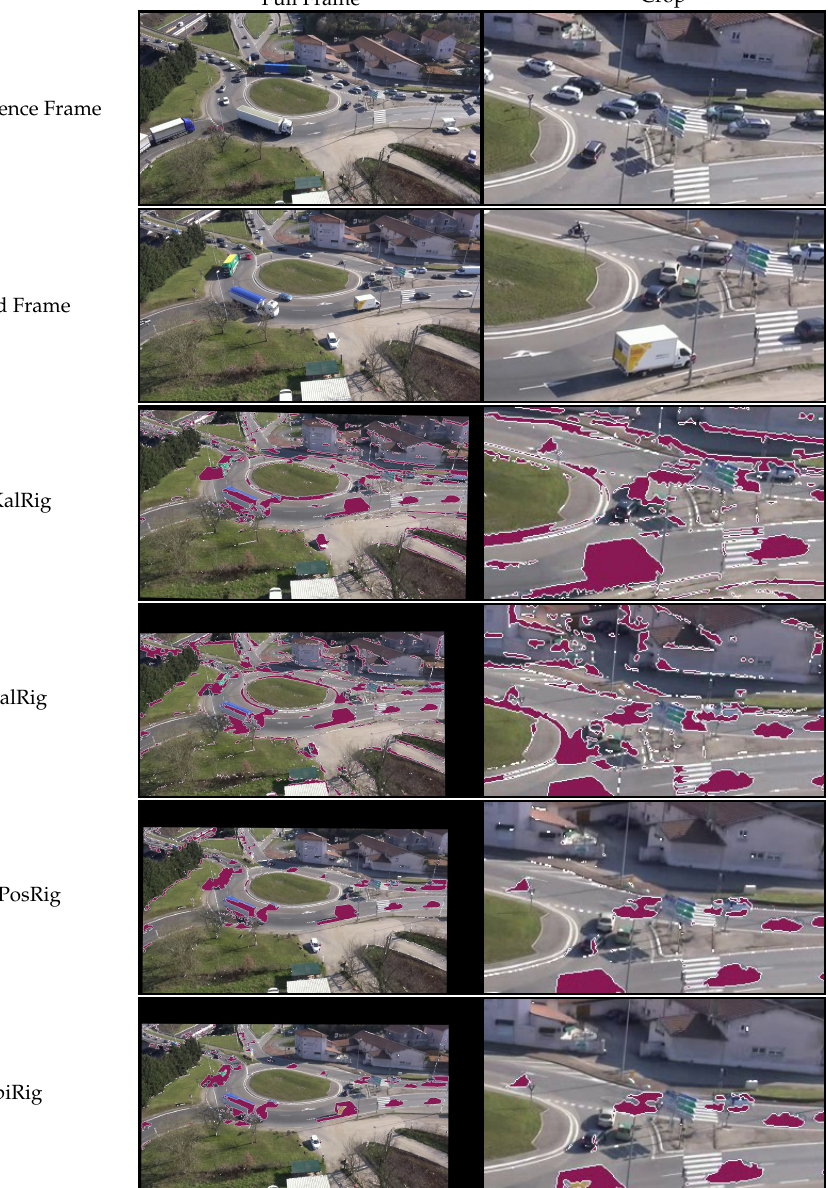
Figure 10. Results from tested 2D-rigid methods on the sequence MFull. The test-frame was picked approximately 38 minutes after the start of the video. To emphasize differences, we have displayed the output of the background subtraction algorithm ViBe [28] on tested configurations (segmented parts in purple, contours in white). The full frame ( center column ) is cropped at a fixed location (right column) to better show details.